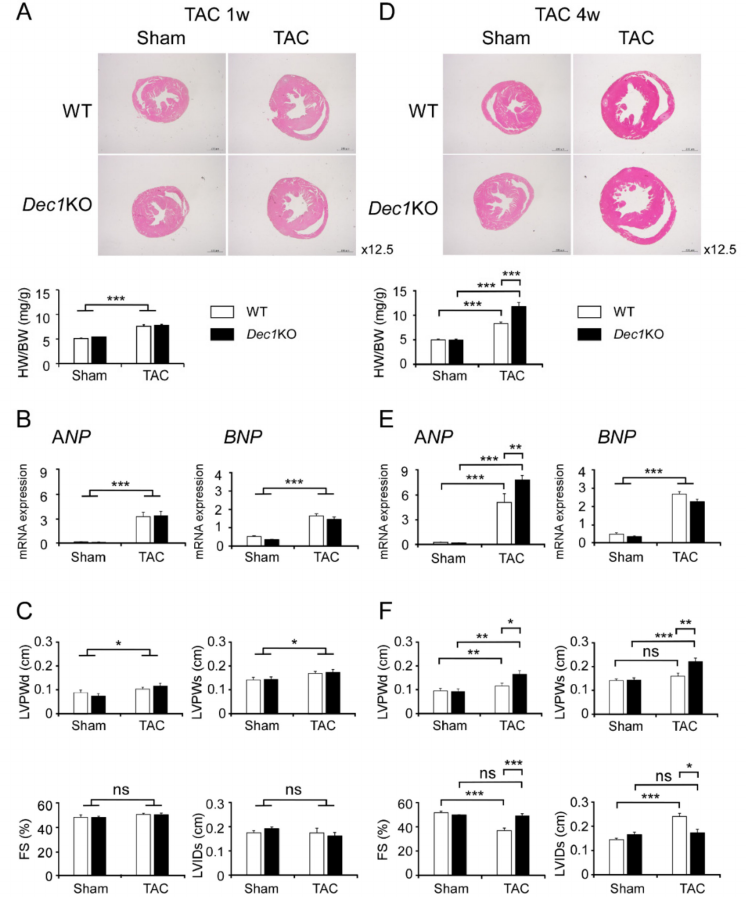
Figure 1. Di ff erentiated embryonic chondrocyte gene 1 ( Dec1 ) deficiency protects cardiac function against transverse aortic constriction (TAC)-induced pressure overload. ( A ) Assessment of cardiac phenotype in wild-type (WT) and Dec1 knock-out ( Dec1 KO) mice at one week (1w) after TAC ( n = 11–13 mice per group) and sham treatment ( n = 5–6 per group). Hematoxylin and eosin (H&E) staining of WT and Dec1 KO hearts, magnification 12.5 × . Heart weight / body weight (HW / BW). White box indicates WT and black box indicates Dec1 KO. ( B ) The relative messenger RNA (mRNA) expression of the hypertrophy markers, ANP (atrial natriuretic peptide) and BNP (B-type natriuretic peptide), in WT and Dec1 KO mice at one week after TAC and sham. ( C ) Echocardiographic analysis of WT and Dec1 KO mice at one week after TAC and sham. FS: fractional shortening; LVIDs: left ventricular internal dimension at the end of systole; LVPWd and LVPWs: left ventricular posterior wall thickness at the end of diastole and at the end of systole, respectively. ( D ) Assessment of cardiac phenotype in WT and Dec1 KO mice at four weeks (4w) after TAC and sham treatment ( n = 8–11 per group). ( E ) The relative mRNA expression of the hypertrophy markers, ANP and BNP , in WT and Dec1 KO mice at four weeks after TAC and sham treatment. ( F ) Echocardiographic analysis of WT and Dec1 KO mice at four weeks after TAC and sham treatment. Multiple comparisons between sham and TAC groups were analyzed by two-way ANOVA with Tukey–Kramer post hoc test. Data are the means ± standard error of the mean (SEM). * p < 0.05, ** p < 0.01, *** p < 0.001; NS: not